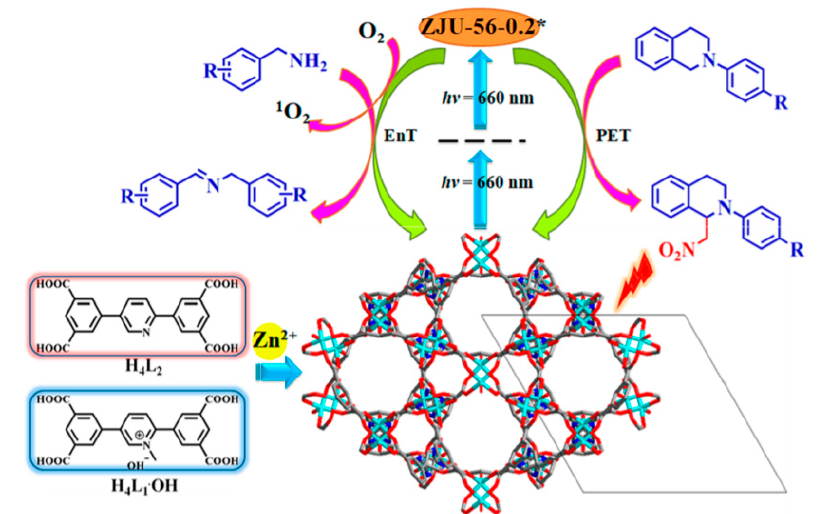
Figure 15. Construction of ZJU-56 for two-photon absorption processes, containing pyridine and hydroxypyridinium fragments. Adapted with permission from Reference [33], Copyright (2019) American Chemical Society.